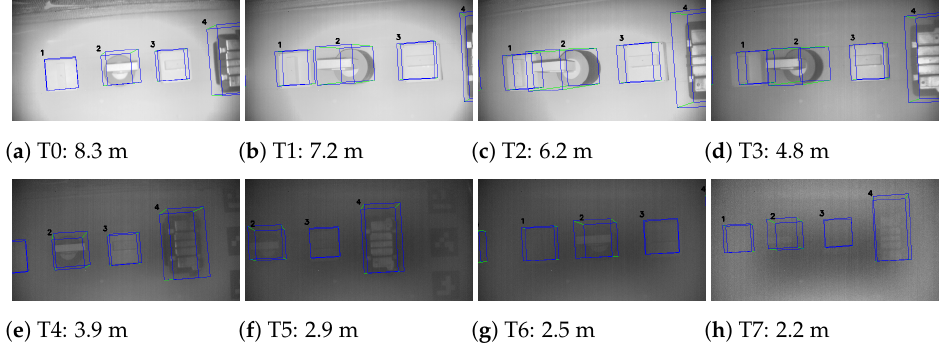
Figure 2. Subsea panel with projected ground truth pose as seen across turbidities. Images were acquired under seven different turbidites, ranging from 8.3 m down to 2.2 m attenuation